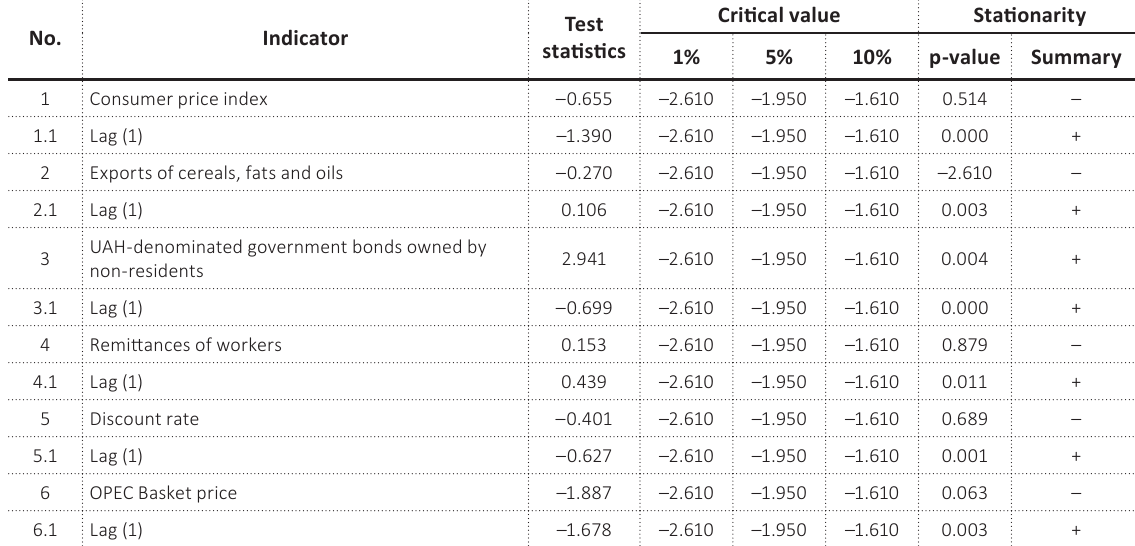
Table C1. Dickey-Fuller test results for all indicators of the VAR-model (suppress constant